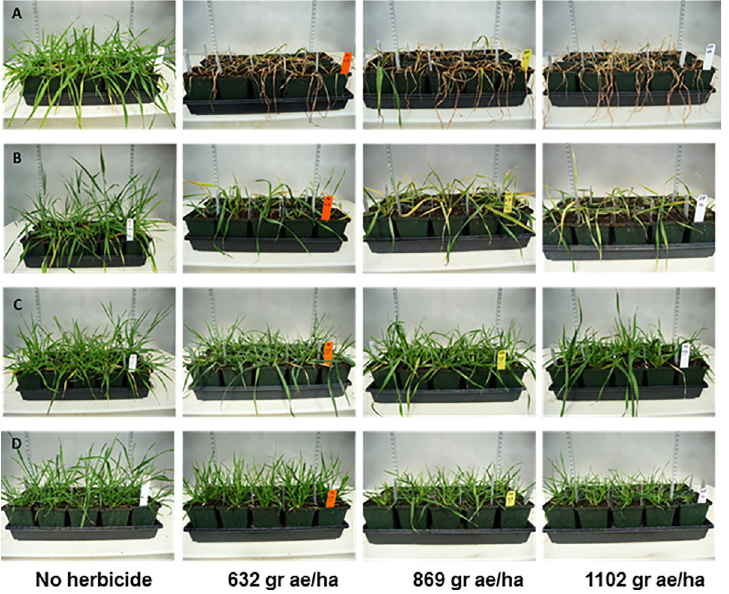
Fig 5. Greenhouse glyphosate spray chamber tests of different wheat genotypes. Row A represents the un- mutagenized parental cultivar Express. Row B is the homozygous triple mutant line (genotype II in Fig 3B). Row C shows the genotype with the homozygous TIPS alleles on chromosomes 7A and 7D EPSPS homoeologs (genotype III in Fig 3B). Row D represents the genotype with TIPS mutations as well as the chromosome 4A T 102 I allele (genotype IV in Fig 3B). Flats contained ~30 plants for each genotype except row B whose flats contained 13 plants. Flats were sprayed at the 5-leaf stage with the indicated rate of grams acid equivalent/hectare of Roundup PowerMAX 1 . Images were taken two weeks after herbicide